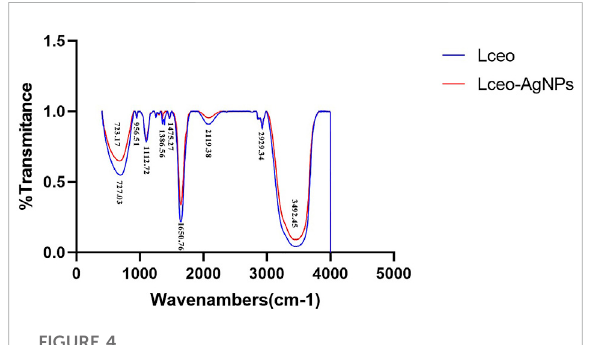
FIGURE 4 FTIR absorption spectra of Lceo-AgNPs and